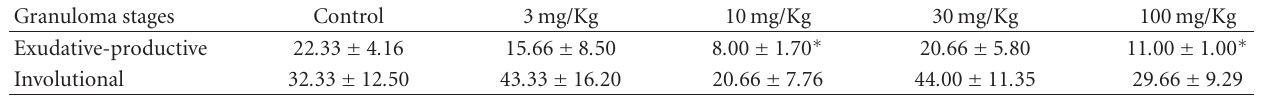
Table 2: Hepatic granulomas of mice infected by S.mansoni and treated with LPSF/PT05-PEG. Granuloma